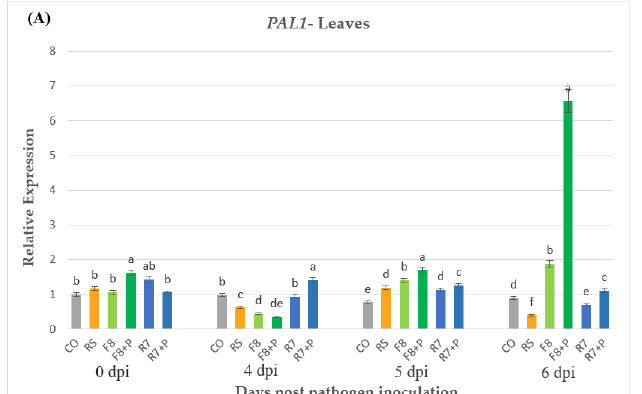
Figure 8. Effects of Streptomyces strains on LOXB gene expression in tomato leaves at different time points in plants inoculated with Rhizoctonia solani AG4. Statistically, values of each column indicated by the same letters (a–d) have no significant differences according to LSD test ( p ≤ 0.05). CO: Control treatment without pathogen and Streptomyces ; RS: Rhizoctonia solani (pathogen); F8: Streptomyces globisporus strain F8; F8 + P: S. globisporus strain F8 + Pathogen; R7: Streptomyces praecox strain R7 and R7 + P: S. praecox strain R7 + Pathogen. Dpi: day post inoculation with the pathogen; 0 dpi implies the first hours of pathogen infection. Although a downregulation of PAL1 gene in leaves was noticed in S. globisporous strain F8-treated plants at 4 dpi, the expression level of this gene increased consistently and reached the highest expression (5.7-fold higher than untreated unchallenged control) at 6 dpi. There was also a significant difference between levels of PAL1 expression in plants treated with S. globisporous strain F8 before and after the pathogen inoculation at 6 dpi. An induction of a stronger defensive reaction was noticeable in pathogen-challenged plants compared to unchallenged controls. In S. praecox strain R7 treated plants, a minor